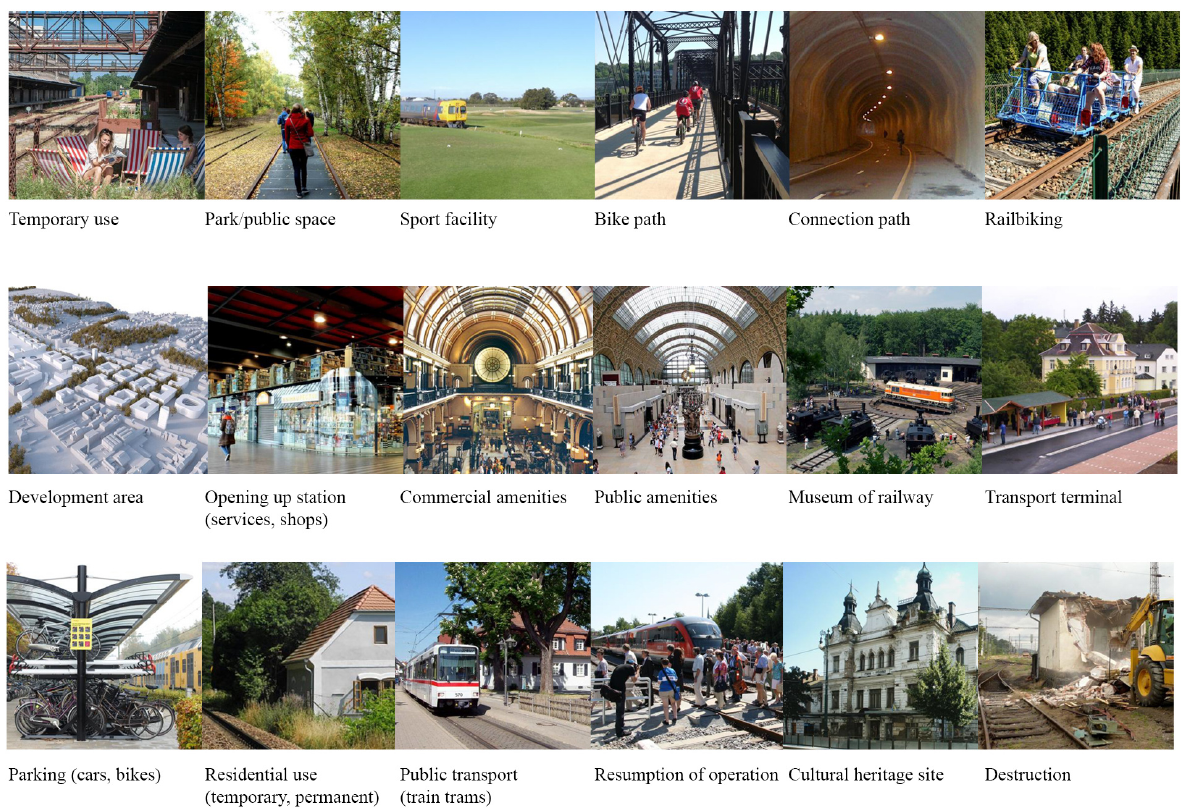
Figure 2. Possible new functions of unused railway areas